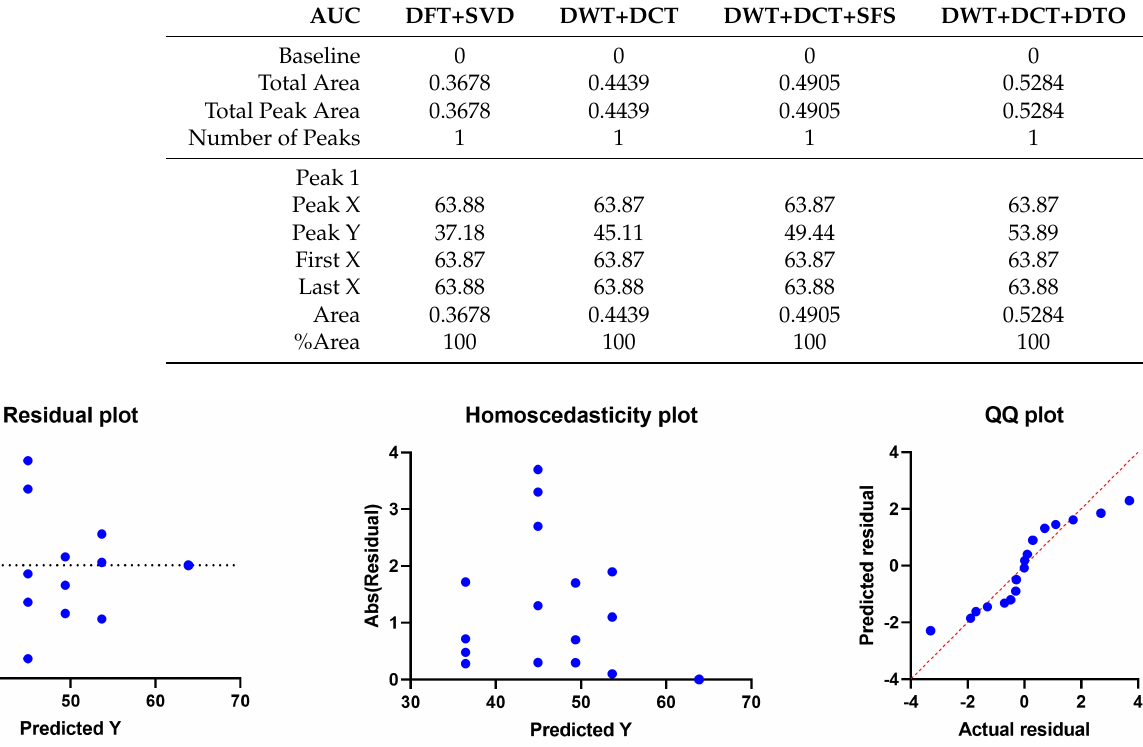
Figure 7. The residual, homoscedasticity, and QQ plots of the results achieved by using the pro- posed approach.